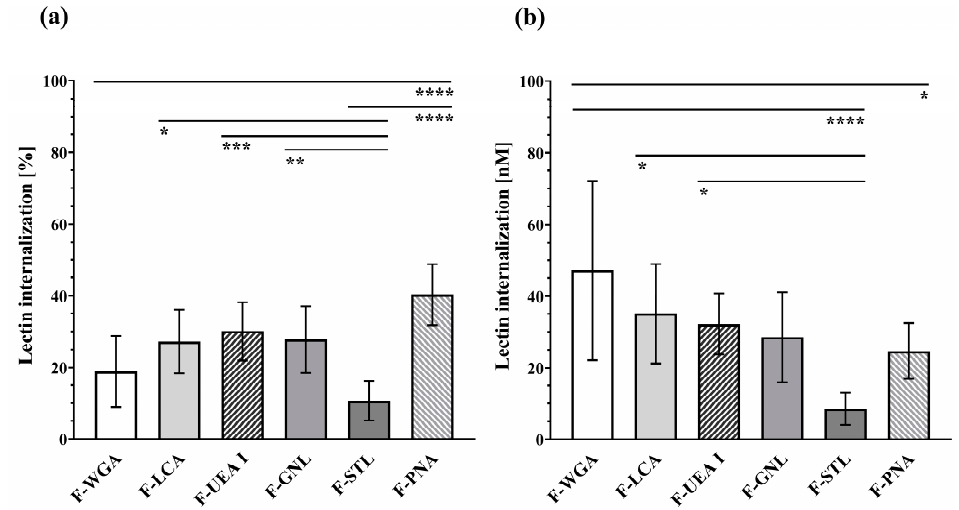
Figure 5. Internalisation of lectins at 37 °C. Values represent the ( a ) relative (%) and ( b ) absolute (nM) uptake of mucosa-bound lectins at 4 °C after a temperature increase to 37 °C. * p ≤ 0.05; ** p ≤ 0.01; *** p ≤ 0.001; and **** p ≤ 0.0001.